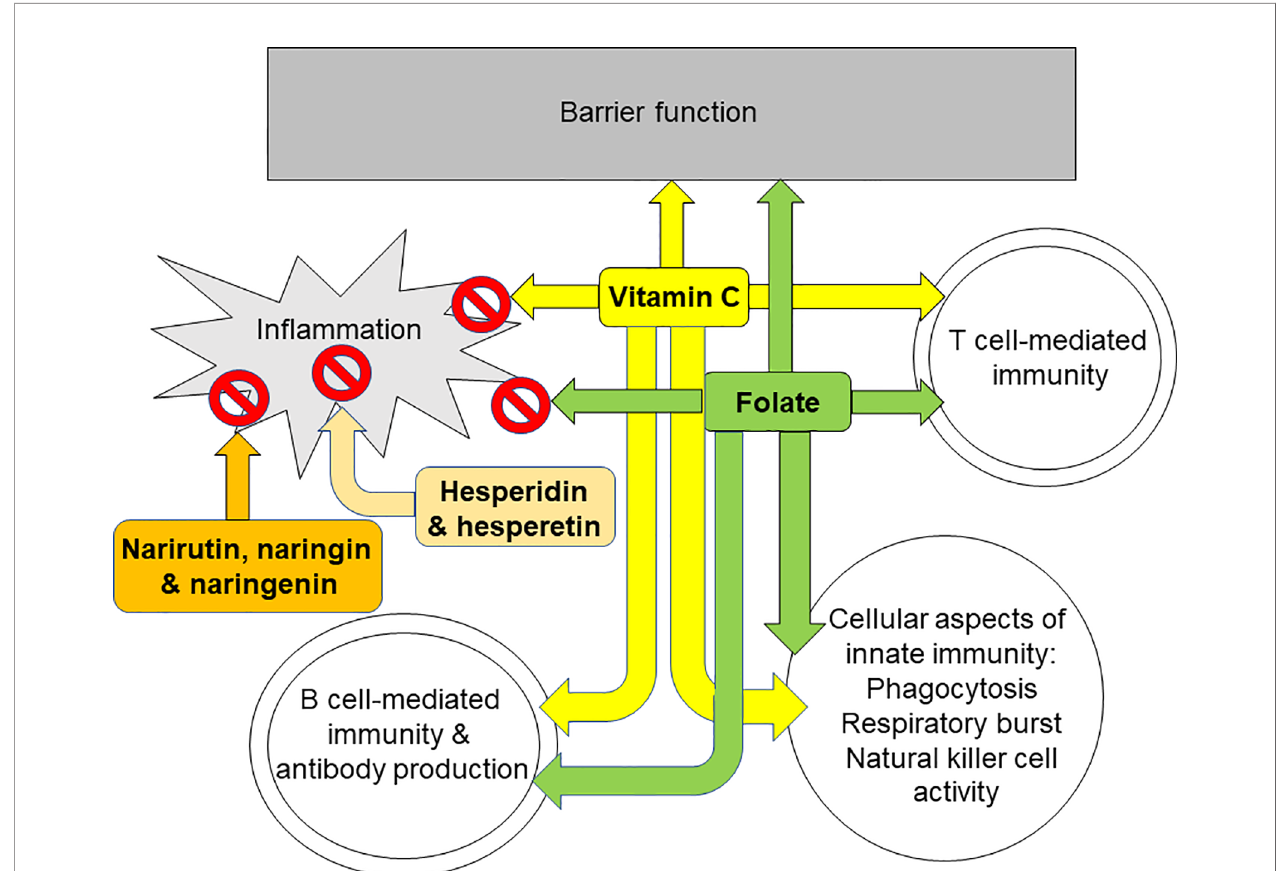
FIGURE 4 | Summary of the effects of orange juice bioactives on different aspects of in fl ammation and immunity. Vitamin C and folate support barrier function, T cell mediated immunity and B cell mediated immunity. Vitamin C, folate, hesperidin and its aglycone hesperetin, and narirutin and naringin and their aglycone naringenin all reduce in fl